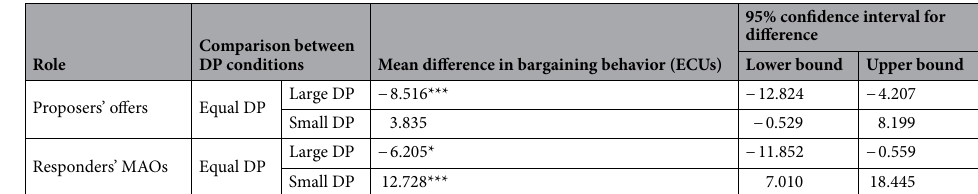
(Table 1). Procedural justice did not affect bargaining behavior across all power conditions (no main or interac- tion effect).